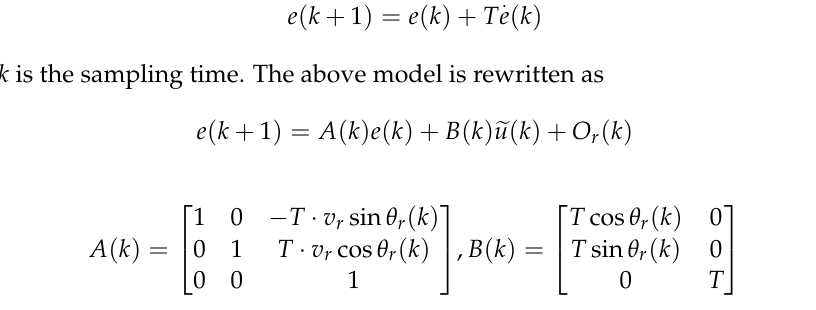
where e represents the following error of the mobile robot; (cid:101) u = u − u r is the change of input control law. In the actual motion process, it is difficult to realize the continuous control of the mobile robot. Therefore, obtaining a discrete-time model of the four-wheel mobile robot is necessary. Setting the sampling period as T , where